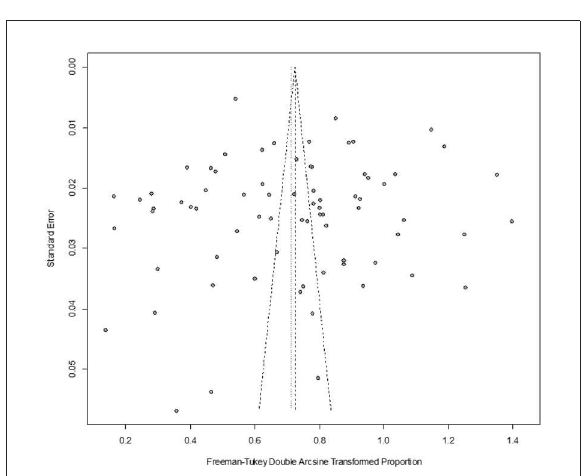
FIGURE7 Funnel plot with pseudo 95% confidence interval limits for the examination of publication bias (decetion